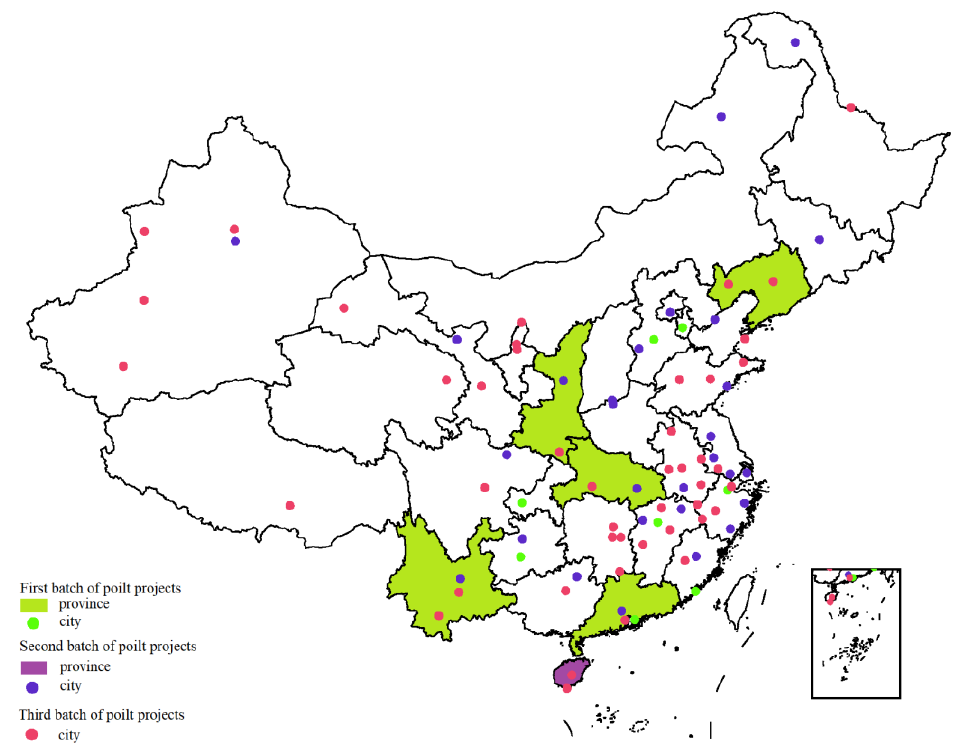
Figure 1. Spatial distribution of three batches of low-carbon pilot regions in China.